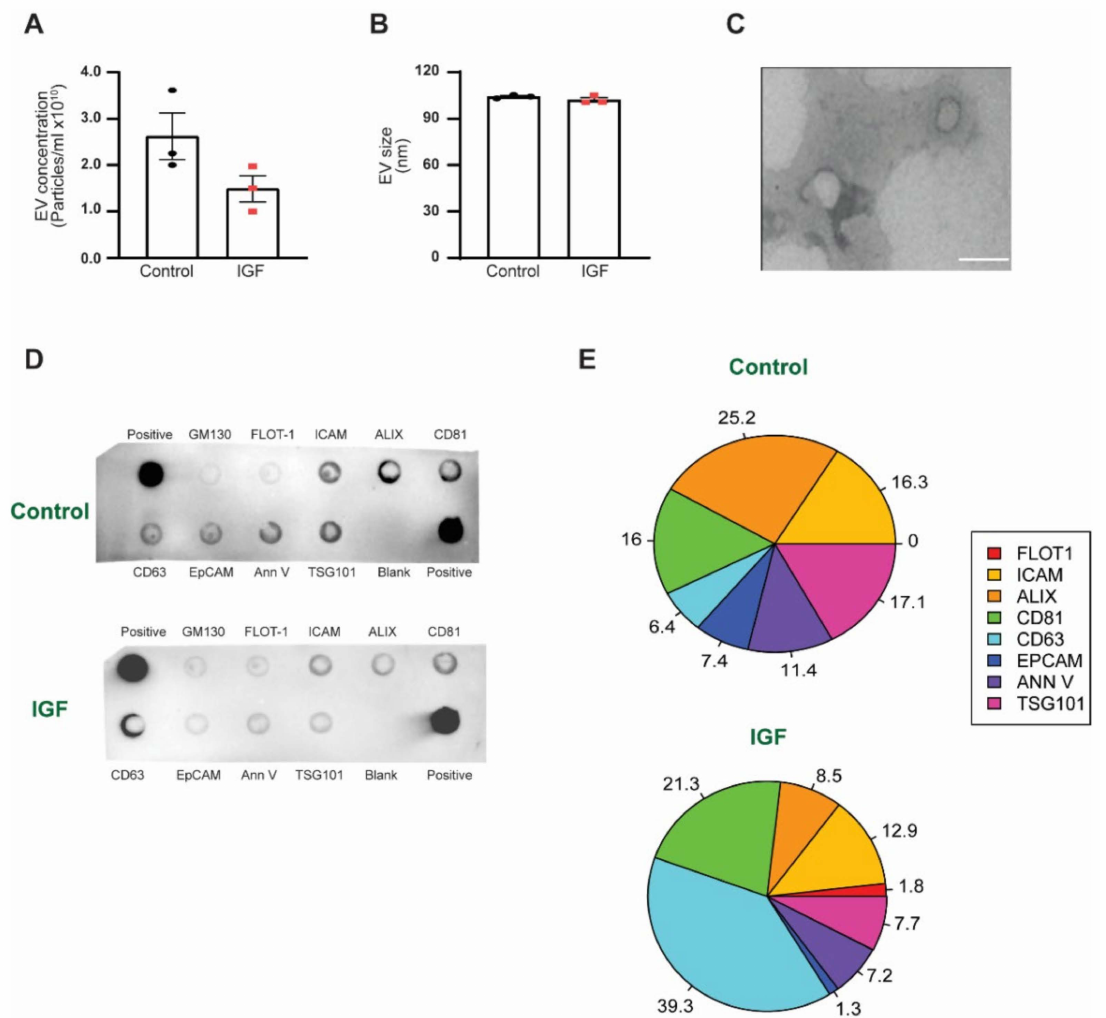
Figure 1. Characterization of myotube-derived EVs: ( A )—myotube-derived EV control (control) and IGF-treated myotube- derived EV (IGF) concentration; ( B )—EV size between the control and IGF; ( C )—representative TEM image of the myotube- derived EVs, scale size 200 nm; ( D )—EV marker protein concentration between the control and IGF; ( E )—pie chart representing the percent of each EV protein markers in the control and IGF. ( A , B ) Data are presented as the mean ± SE ( n =